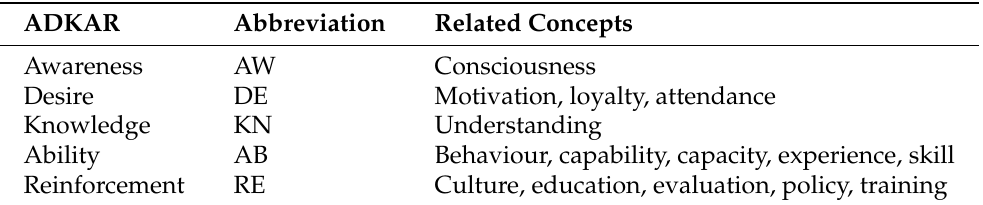
Figure 2. The consideration of the five ADKAR factors over the years, based on the 60 inclusions of our systematic review. Table 5. The ADKAR factors and the related concepts we encountered that were associated with each